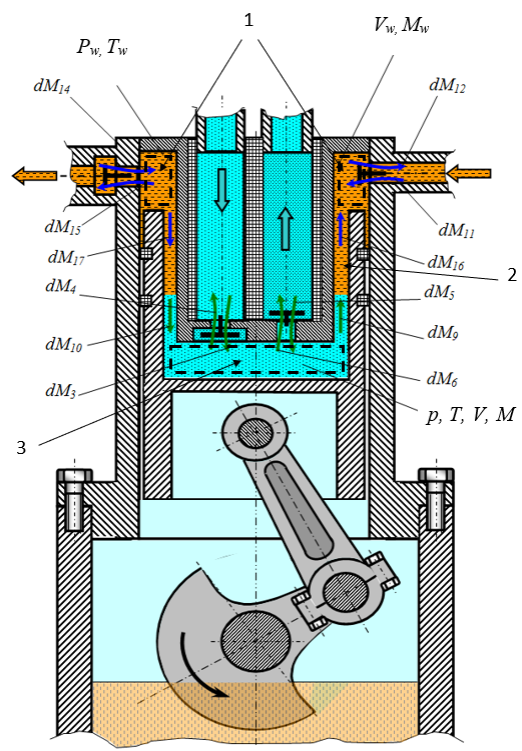
Figure 7. Construction diagram of a crosshead-free PHPM for developing a mathematical model of work processes. (1—displacement of the pump section; 2—gap clearance between the pump and compressor sections; 3—displacement of the compressor section).